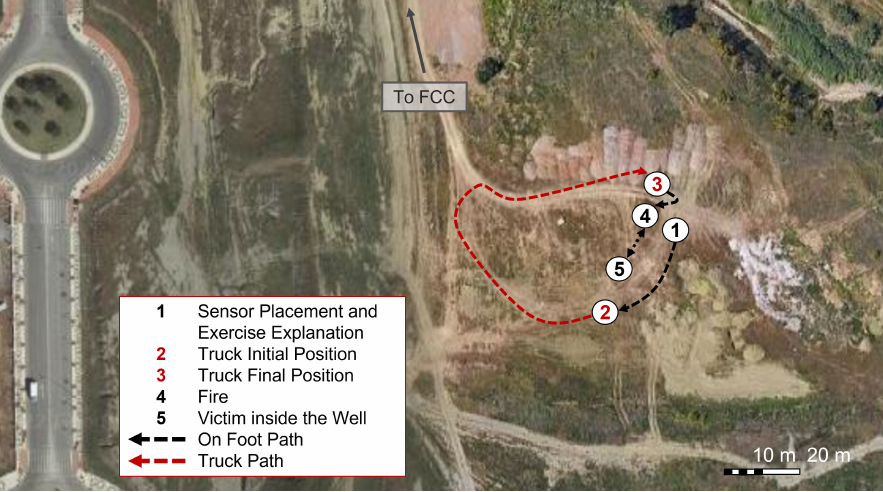
Figure 10. Aerial view [48] of Zone 2. Truck operations in red; on-foot operations in black. Note that fireman moved in both directions between the fire and the victim inside the